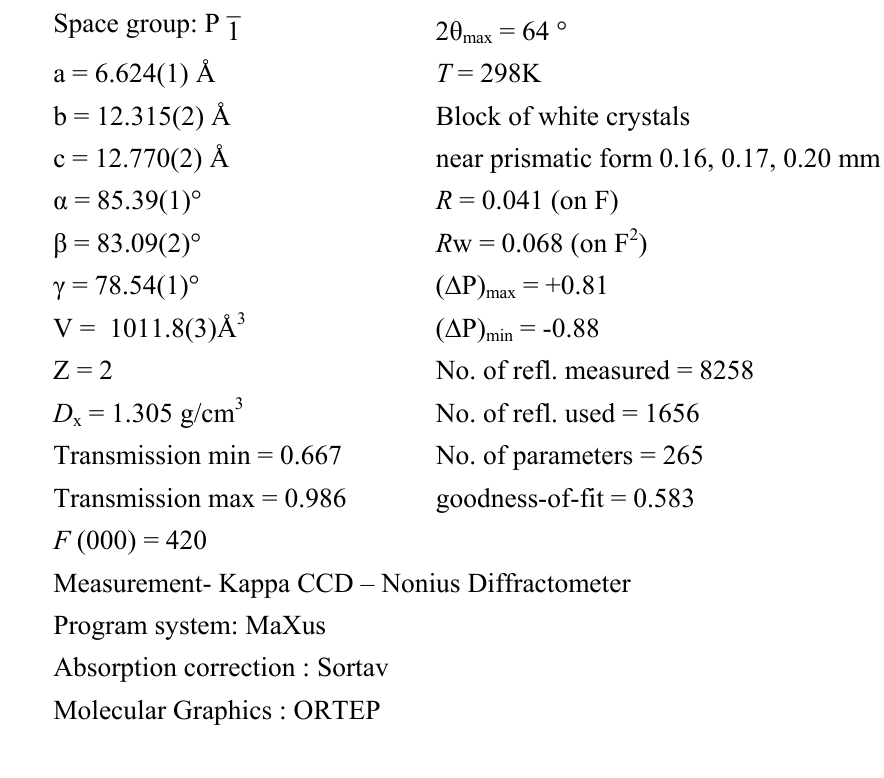
Table 2 : Selected Fractional Atomic Coordinates and